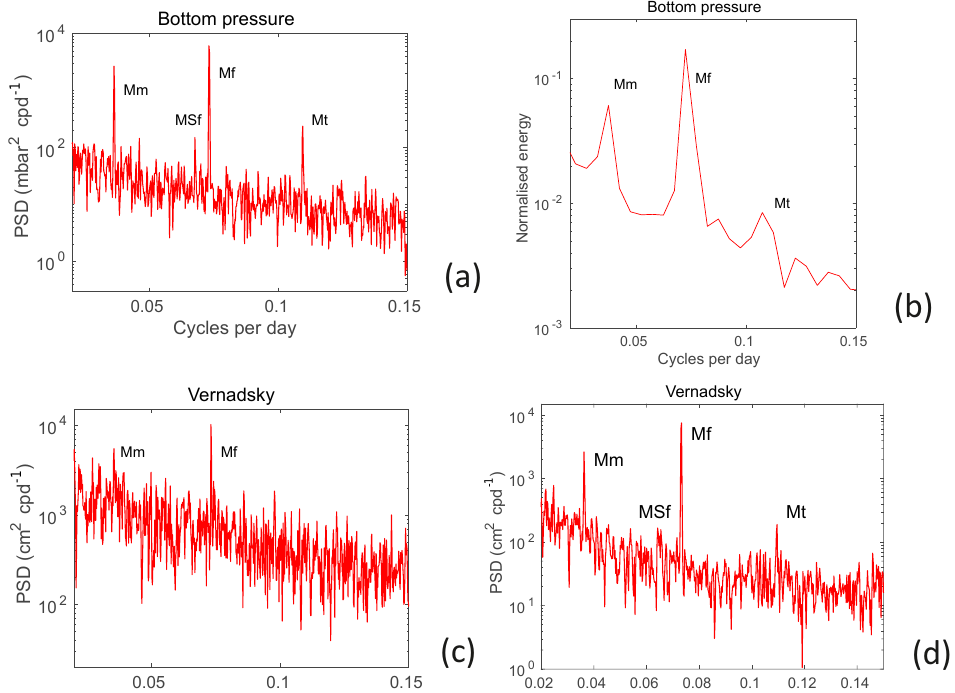
Figure 3. (a) Power spectral density (PSD) between 0.02 and 0.15cpd of a composite, continuous record of daily mean BP in the Drake Passage spanning over 26 years. (b) An averaged, normalised power spectrum typical of each record made from 20 of the 45 BPR time series which had no data gaps for which the standard deviation of the regression fit in terms of three harmonics was at least 50% of that of the times series itself, so ensuring a significant tidal component (also see text). (c) PSD of a record of daily mean sea level at Vernadsky Research Base spanning 1984–2014. Panel (d) is the same as (c) but for a shorter record (1993–2014) and following dynamic atmospheric correction (DAC)